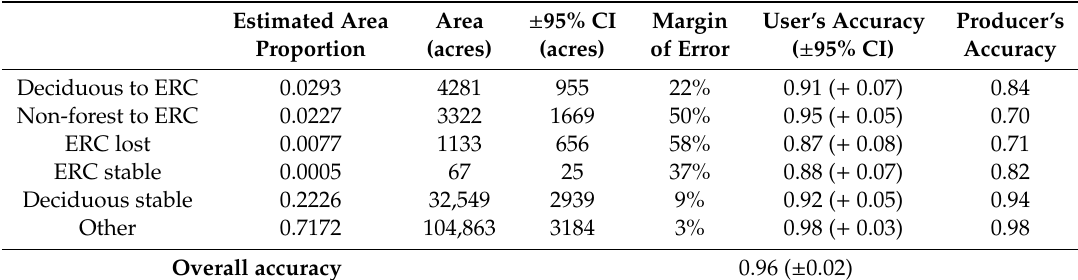
Table 4. Area estimation with 95% confidence intervals—Perry